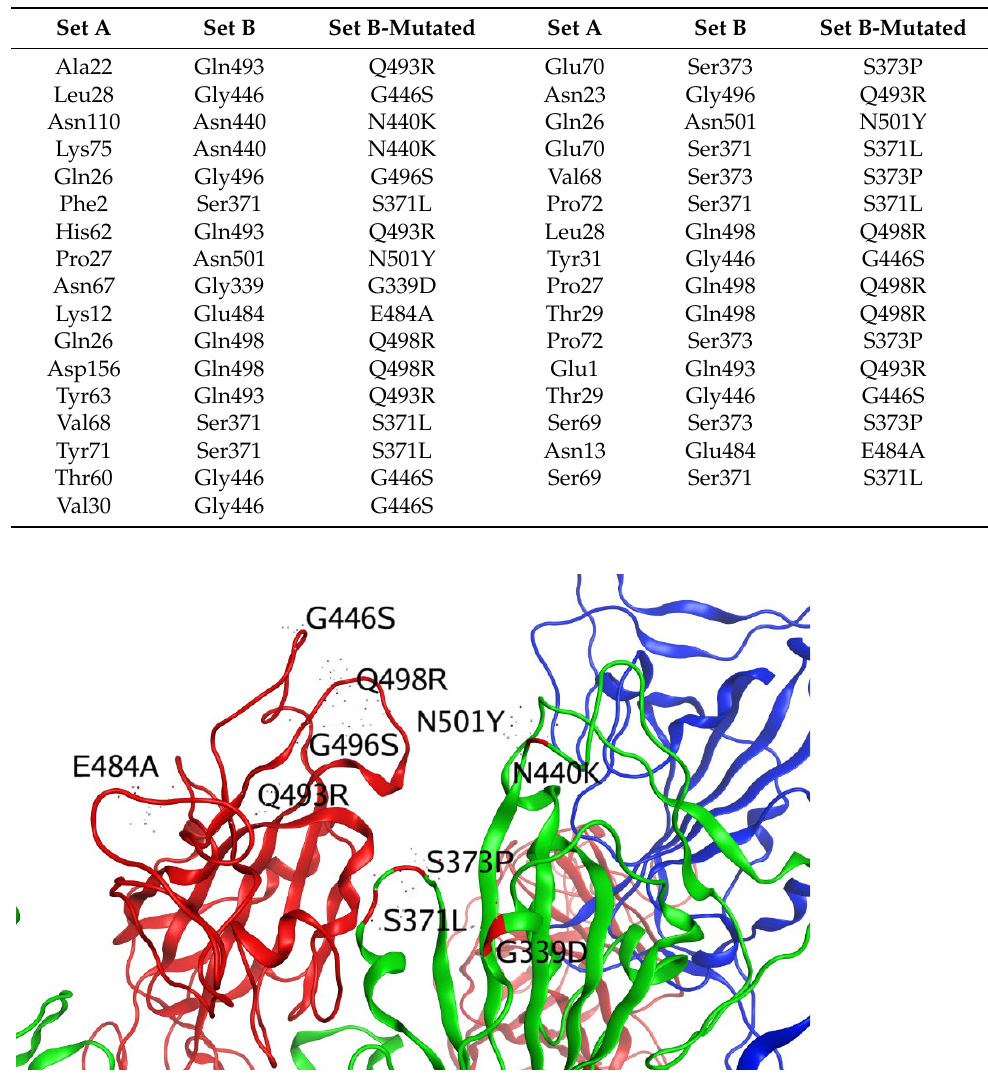
Figure 1. The residues involved in the interaction between the mutated spike protein and the α 7nAChr protein in the Omicron variant. To focus on the mutations, the main spike protein is isolated in the figure. The three different isomers are presented in red, green, and blue, and we highlight how the residues mutate in the Omicron variant. Table 5. The energy state of the bond between the α 7nAChr and (A) main spike, (B) Delta, and (C) Omicron variants of spike protein. The explanation of each energy feature in the first row is described in Table